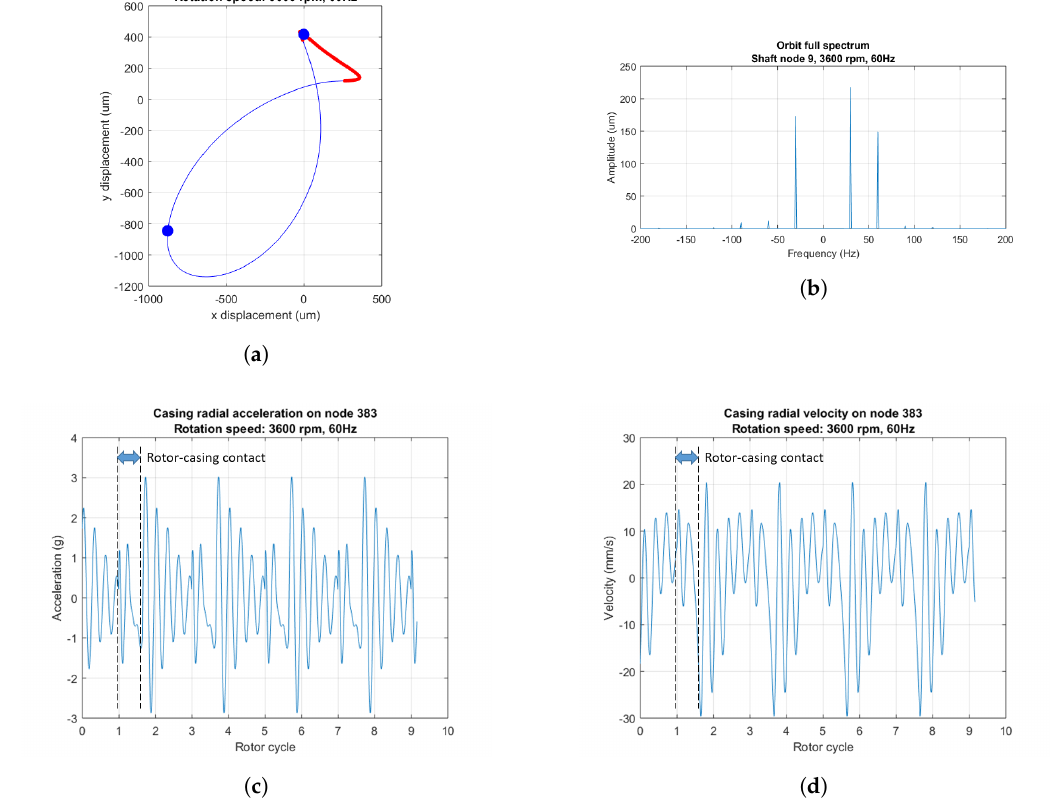
Figure 9. ( a ) Rotor orbit, with the orbit segment where the rotor rubs the casing marked in red; ( b ) full spectrum of the rotor orbit; ( c ) acceleration time plot; and ( d ) velocity time plot at 3600 rpm with single-point rub ( (cid:101) = 2.5 × 10 − 4 m). The shaft rotates in the anticlockwise direction. In ( c , d ), black dotted lines mark the boundaries of the leftmost rotor–casing